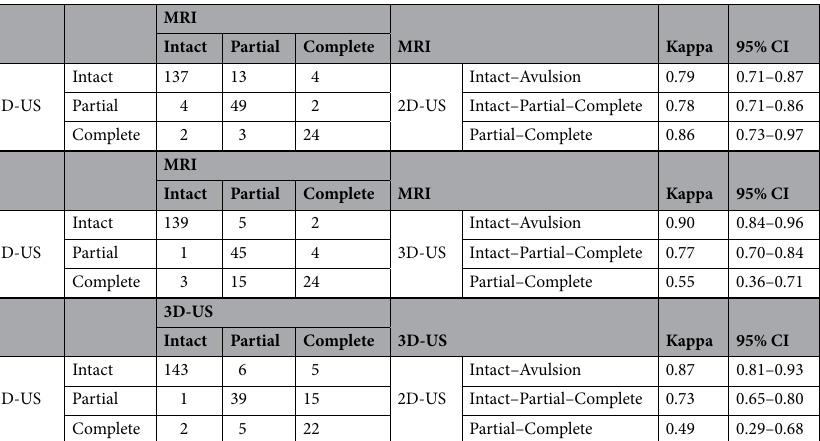
Table 2. Comparison of the agreement on the grading of levator ani defects between the MRI, three- dimensional ultrasonography and two-dimensional ultrasonography. Avulsion including partial avulsion and complete avulsion, Intact no avulsions, Partial partial avulsion, Complete complete avulsion, MRI magnetic resonance imaging, 2D-US two-dimensional ultrasonography, CI confidence interval, 3D-US , three- dimensional